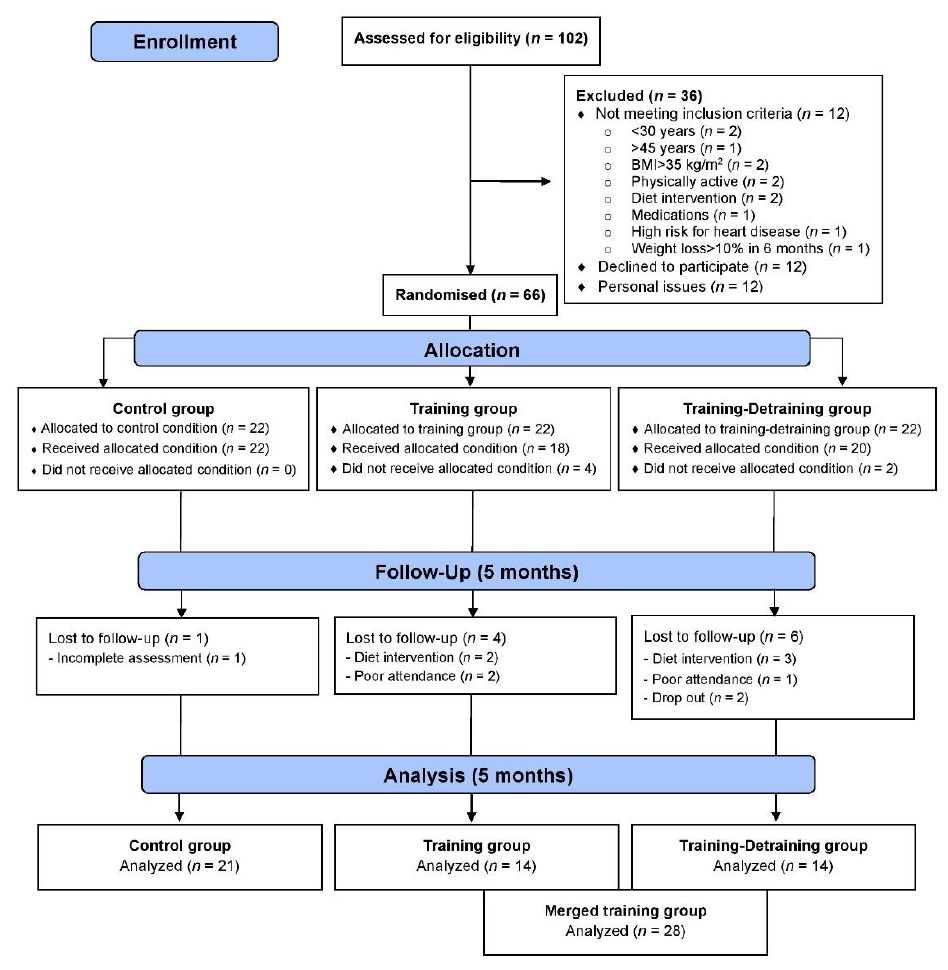
Figure 1. CONSORT flow diagram of the study.